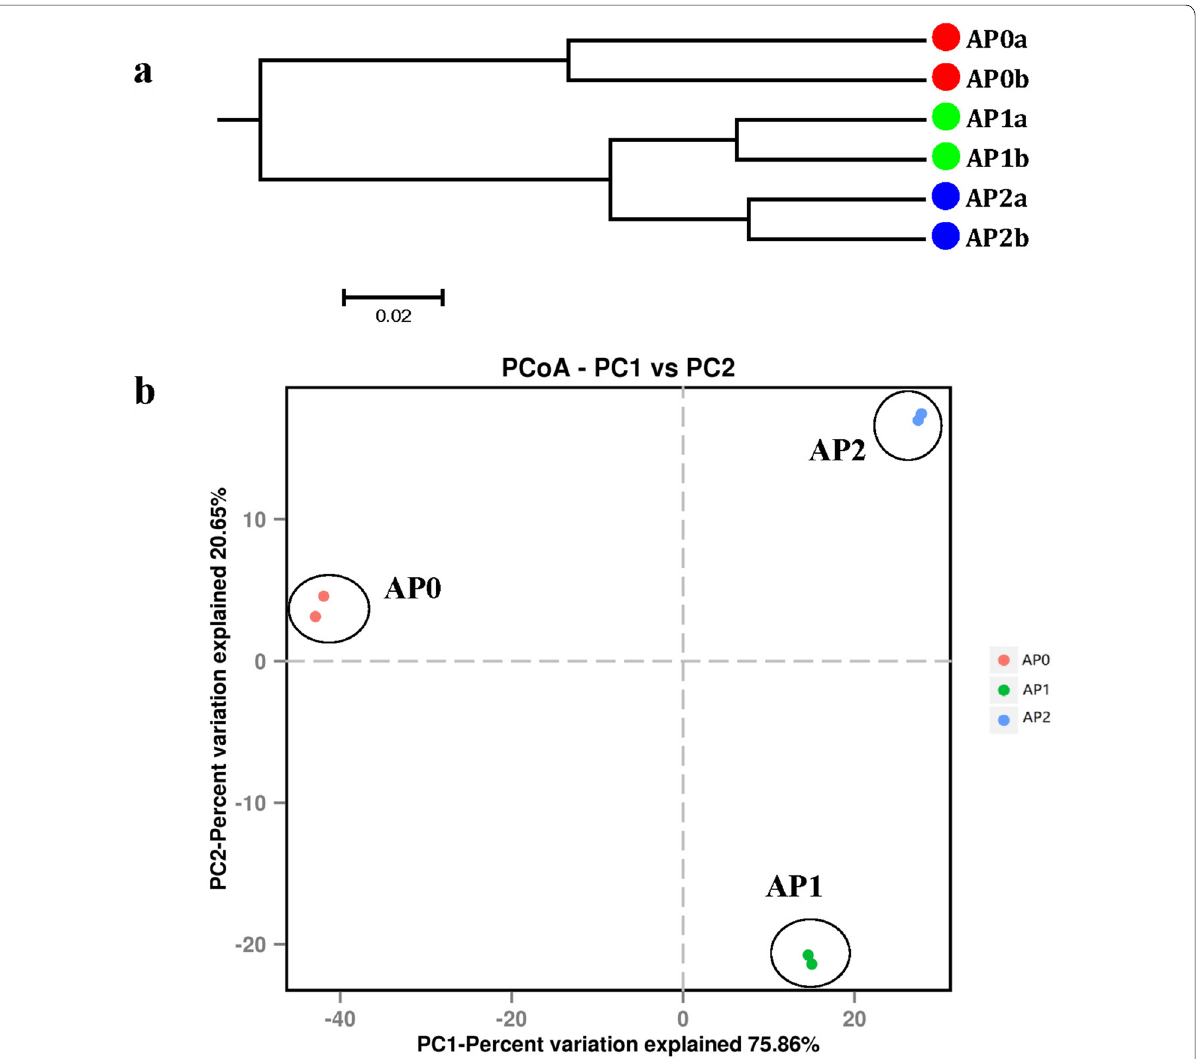
Fig. 2 Unweighted pair-group method with arithmetic mean (UPGMA) dendrogram ( a ) and principal coordinate analysis (PCoA) ( b ) of bacterial communities based on Bray–Curtis distance. AP0, AP1 and AP2 represent soils with continuously cropping histories of Andrographis paniculata for